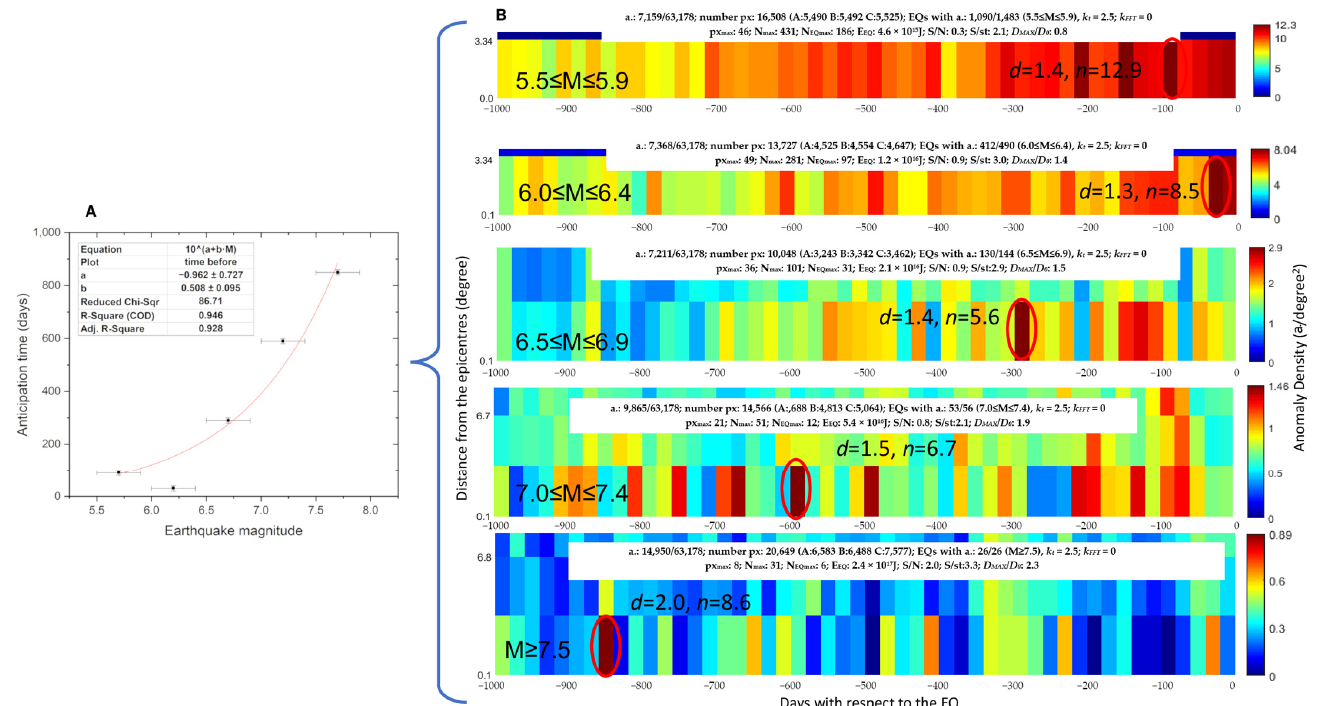
Figure 2. Correlation of Swarm magnetic field anomalies with earthquakes divided into five magnitude bands. ( A ) Fit of the anticipation time of maximum concentration (underlined by a red circle in subfigure ( B ) as a function of earthquake magnitude using the equation ∆ T = 10 a + b · M . The error bar takes into account the width of the pixel. ( B ) Details of the analysis in the earthquake magnitude bands of 5.5 ≤ M ≤ 5.9, 6.0 ≤ M ≤ 6.4, 6.5 ≤ M ≤ 6.9, 7.0 ≤ M ≤ 7.4, and M ≥ 7.5. Only the significant part of the superposed space-time graph is represented. The statistical indications of d (how many times the maximum real concentration is higher with respect to the random one) and n (how many standard deviations there are in which the real largest concentration is greater than the random one) are also shown. Such maximum concentrations (as objectively identified by the WSC algorithm) have been highlighted by a red or orange circle (the last one for a less significant concentration in terms of the Rikitake law). The color bar represents the density of the anomalies in terms of the number of anomalies per square degree.